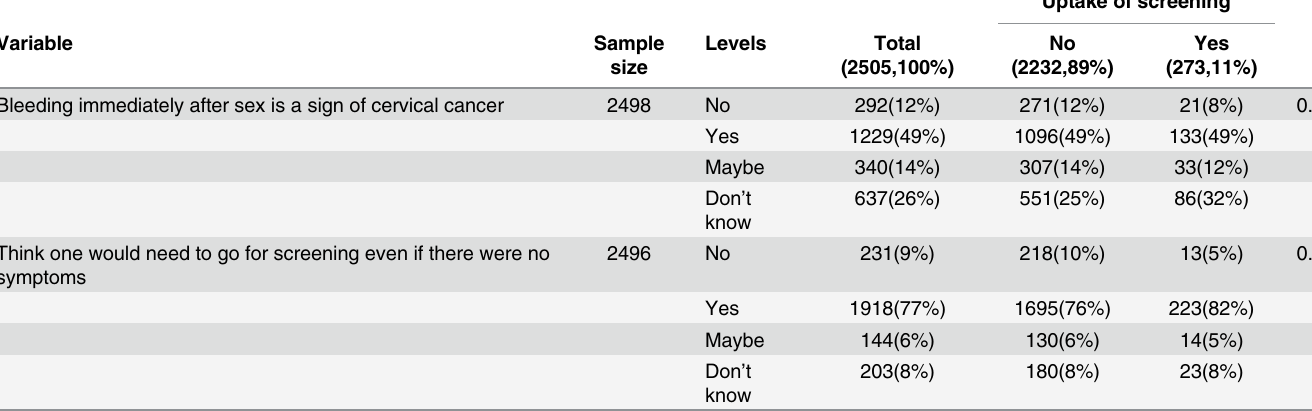
Table 2. Symptoms of cervical cancer.